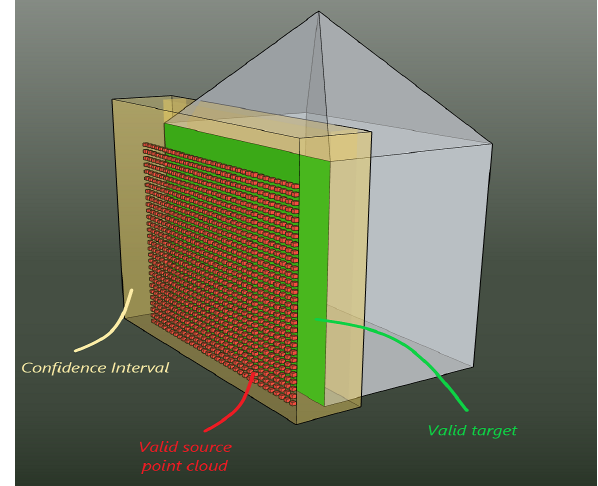
Figure 4. CI (yellow) discretized in L1 norm for a valid LoD 2 building model wall (green) and respective MLS point cloud